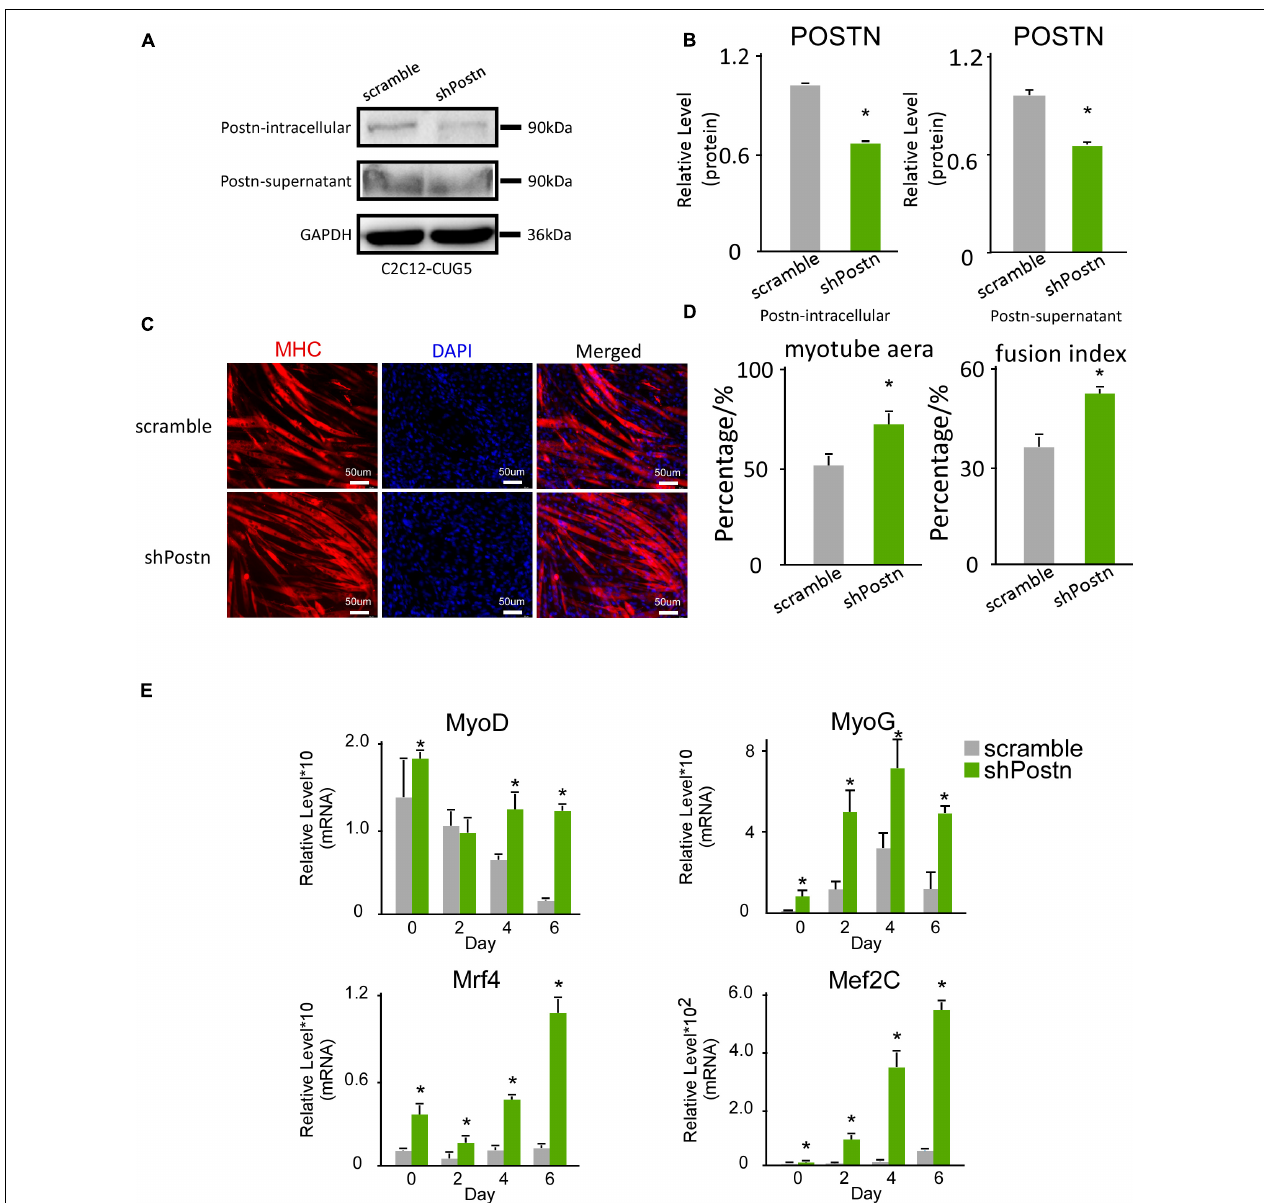
FIGURE 5 | Periostin knockdown promoted myogenesis in normal myoblast cells. (A) Postn knockdown in normal myoblast cells (C2C12 GFP-CUG5), verified by western blots. (B) Gel band intensities from panel (A) quantified with ImageJ software. Values were normalized to GAPDH. (C) Myotube formation in both scrambled control and Postn -knockdown groups, detected by immunostaining against MHC at differentiation day 6. (D) Myotube area and fusion index in both groups quantified with ImageJ software. (E) Expression levels of MRFs ( MyoD , MyoG , Mef2C , and Mrf4 ) in both groups, measured by RT-qPCR. All expression levels were normalized to the values of the scramble control at day 0. Scramble, scramble control normal myoblast cells; shPostn, Postn knockdown normal myoblast cells; * P <